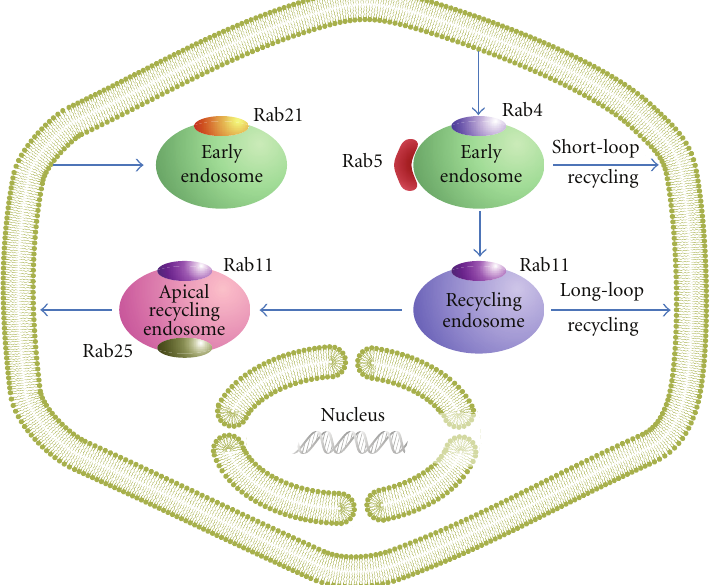
Figure 1: The roles of Rab GTPases involved in integrin tra ffi cking. Integrins can be internalized by a clathrin-dependent, caveolin- dependent, or clathrin- and caveolin-independent pathway. For example, some integrins are internalized by a Rab21 and clathrin- independent pathway. Once internalized, integrins can be recycled back to the plasma membrane by a Rab4-dependent manner or can be transported to the perinuclear recycling compartment. Rab11 family members (Rab11 and Rab25) regulate recycling of integrins from perinuclear recycling compartment. Table 1: Mechanisms of the internalization and recycling of integrins α 5 β 1, α 6 β 4, α v β 3, and α v β 6.